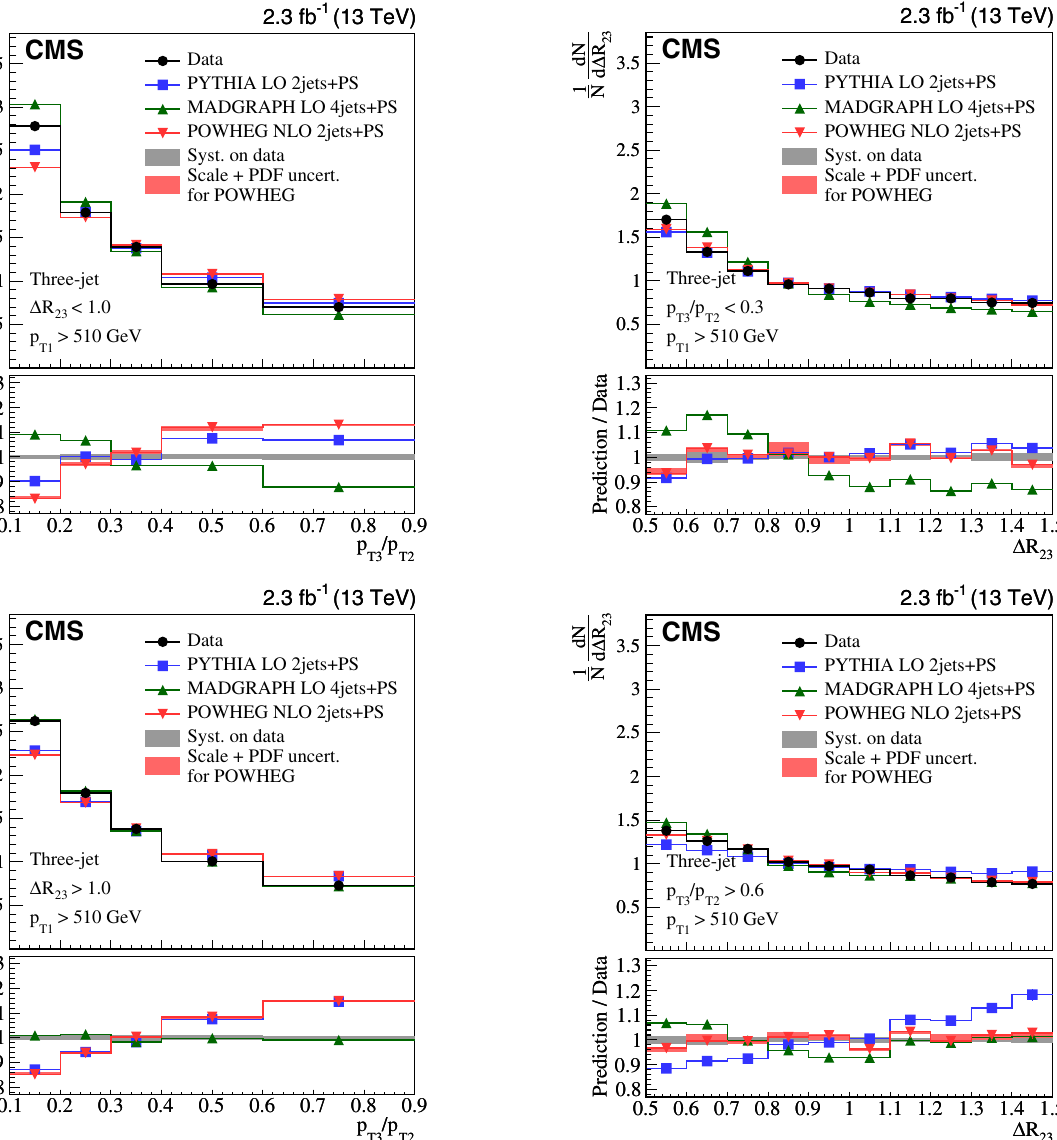
Fig. 4 Three-jet events at p T3 / p T2 for small-angle radiation ( Δ R 23 < 1 . 0), (lower) p T3 / p T2 for large-angle radiation ( Δ R 23 > 1 . 0)